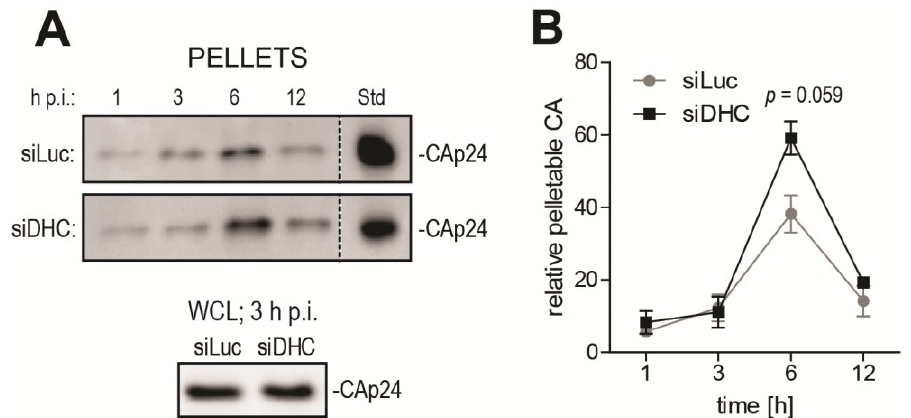
Figure 2. DHC depletion affects HIV-1 uncoating as analyzed using the fate-of-capsid assay. ( A ) Time-course fate-of-capsid assay. HeLa cells were transfected with siRNAs targeting DHC (siDHC) or luciferase (siLuc) and then infected with HIV-1 NL43-GFP for 1 h. Pelletable CA cores were isolated by ultracentrifugation at the indicated times after infection and analyzed by Western blotting (upper panels). Also shown is a Western blot analysis of CAp24 in whole cell lysates (WCLs) at 3 h p.i. (lower panel). Identical amounts of a control CAp24-containing sample were included in each gel as an internal standard (“Std”); ( B ) Bands corresponding to pelletable CAp24 were quantified by densitometry up to 12 h p.i. and plotted after normalization to the standard. Mean values from two independent experiments are shown, with standard errors of the mean